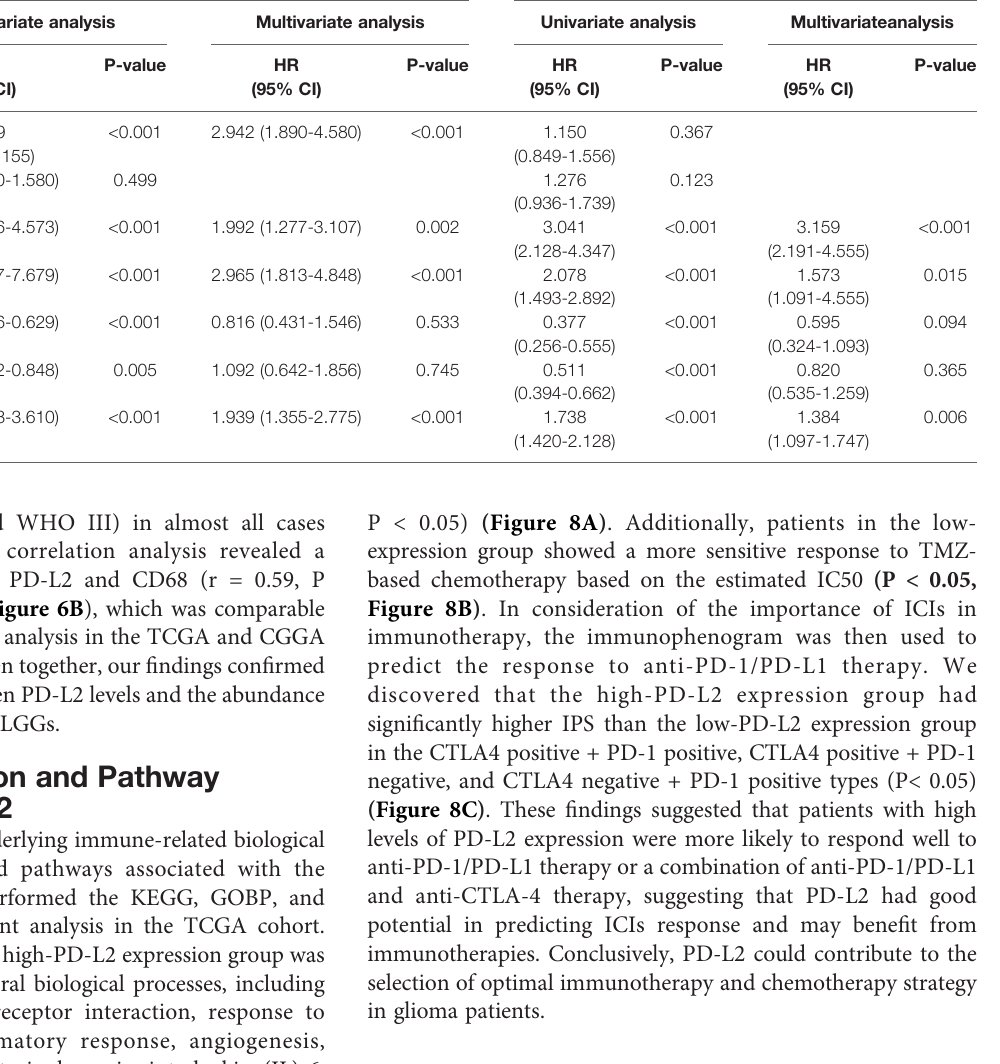
TABLE 2 | Univariate and multivariate analysis of association of PD-L2 and prognostic factors with overall survival in LGGs based on the TCGA and CGGA databases.